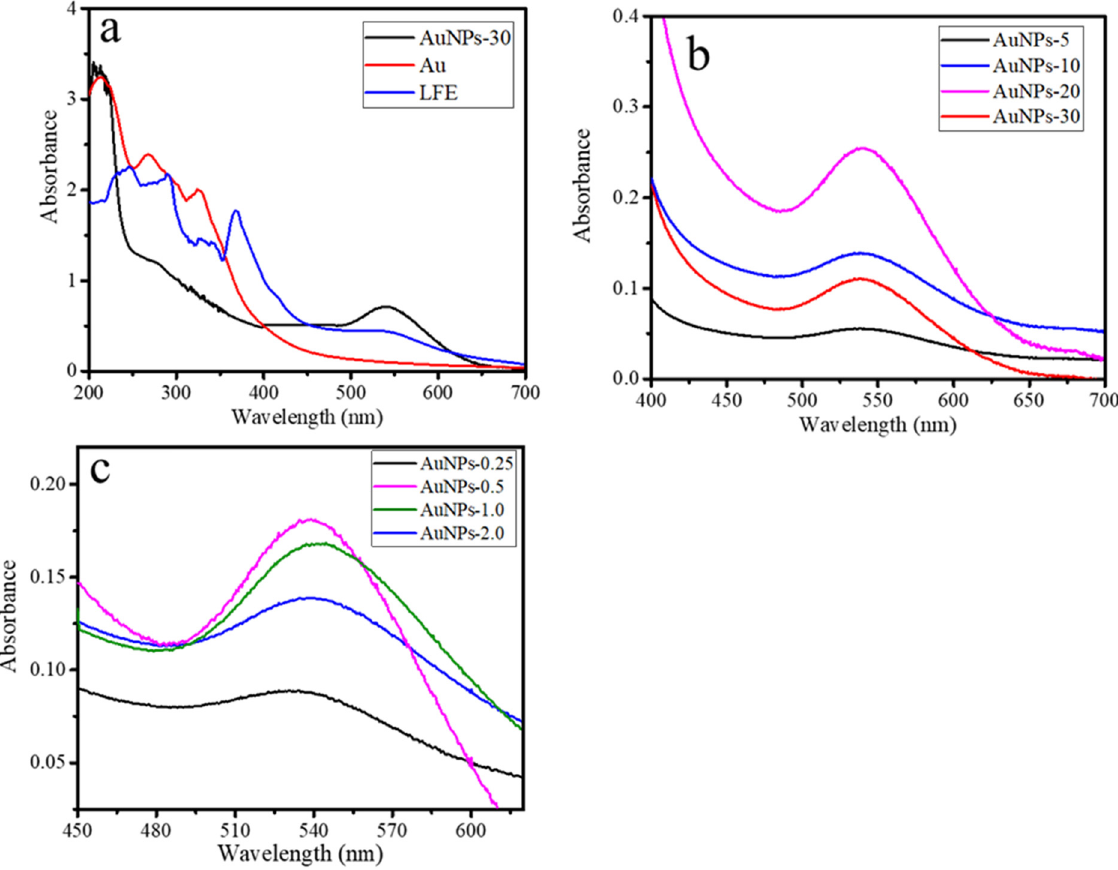
Figure 1: UV - Vis spectra of ( a ) AuNPs in comparison with Au 3 + and LFE. ( b ) AuNPs at varied time of light irradiation, ( c ) AuNPs at varied LFE